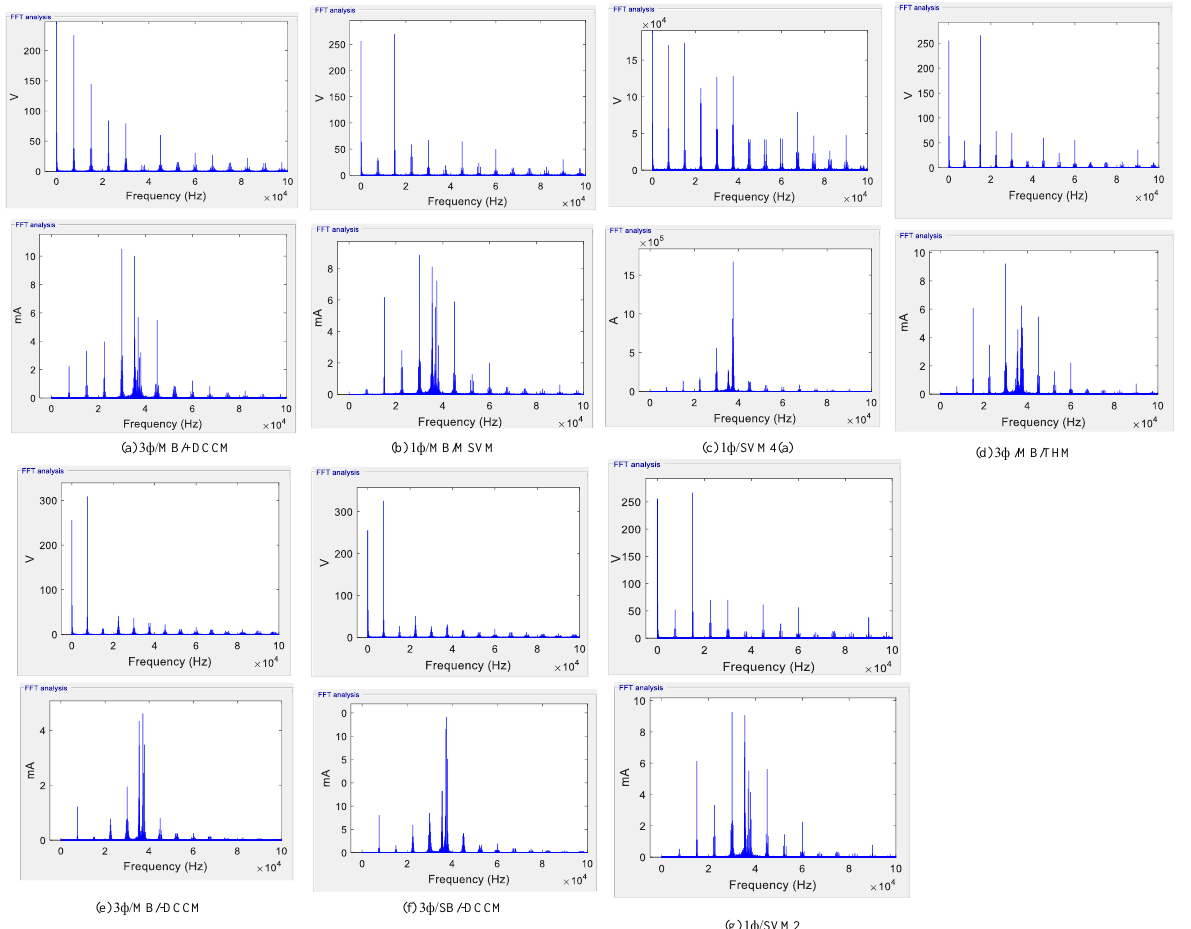
Figure 16. FFT simulation results show the lowest and largest leakage current and CMV values.